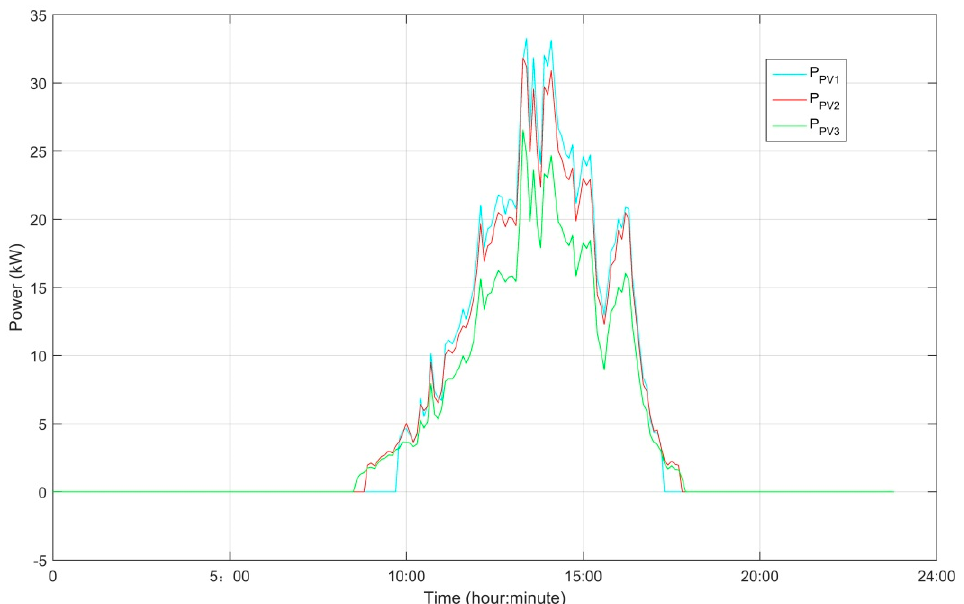
Figure 23. Solar power.